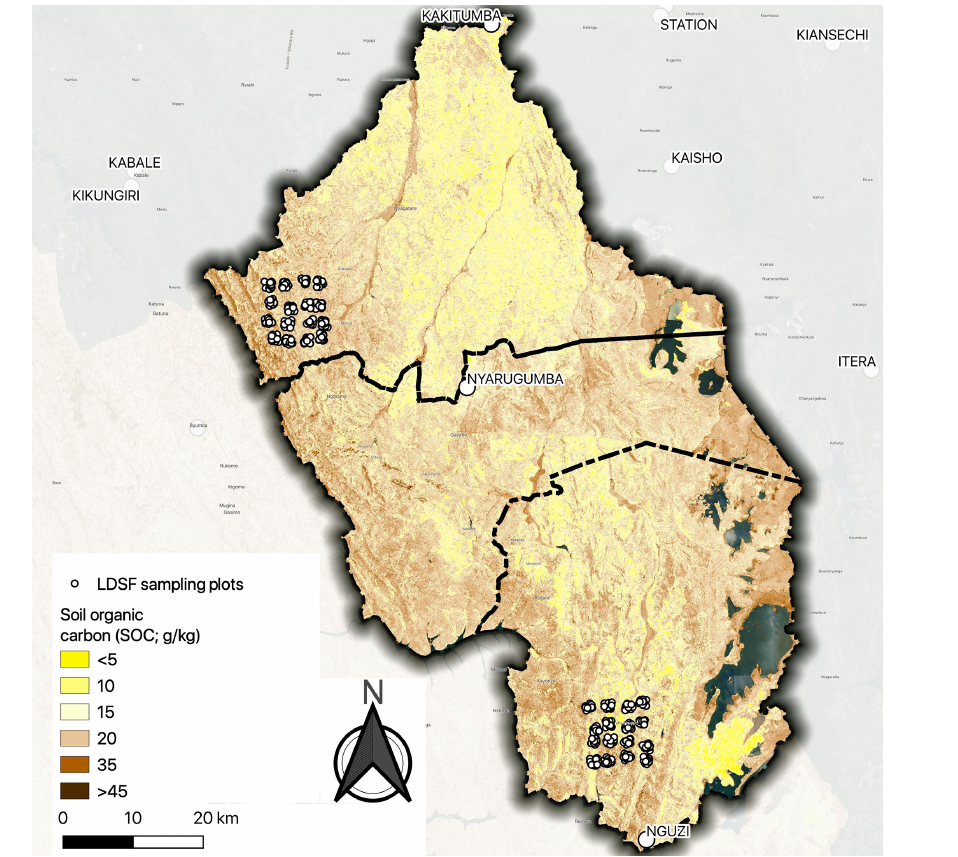
Figure 10. Map of SOC across Nyagatare, Gatsibo, and Kayonza districts (Eastern Province, Rwanda) predicted based on Landsat 8 satellite imagery and soil data from the LDSF plots. The two sites are also shown on the map (Nyagatare in the north and Kayonza in the south), with the sampling plots shown as white